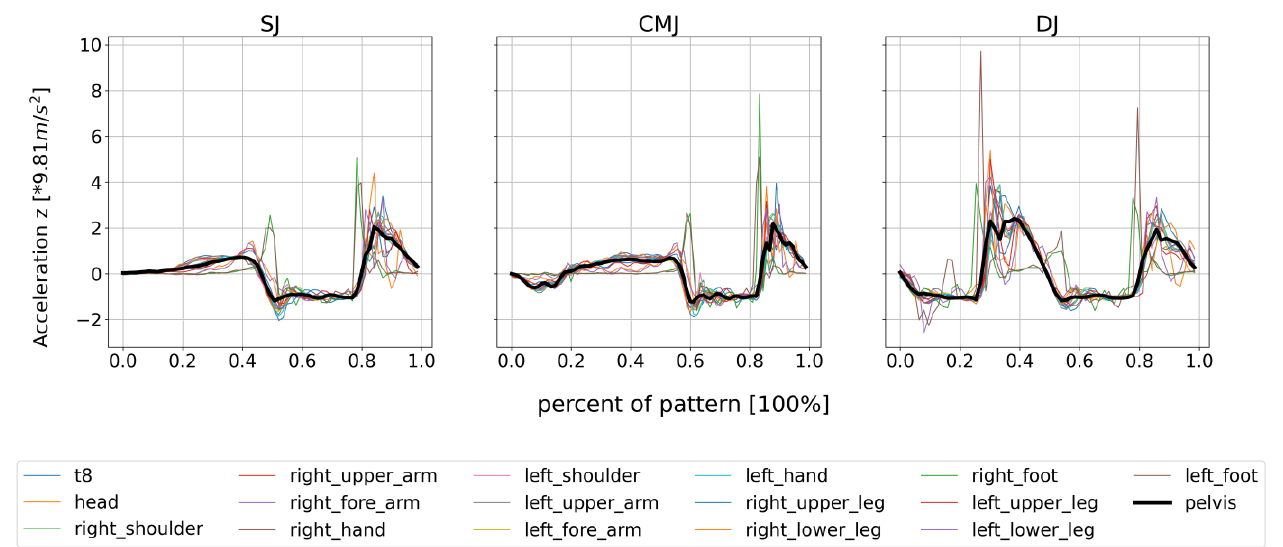
Figure 2. Acceleration curves of all 17 sensors during the jumping exercises, illustrated on a single subject for the third trial each. The acceleration is given as a multiple of the acceleration due to gravity.